Question: Name the type of graph shown.
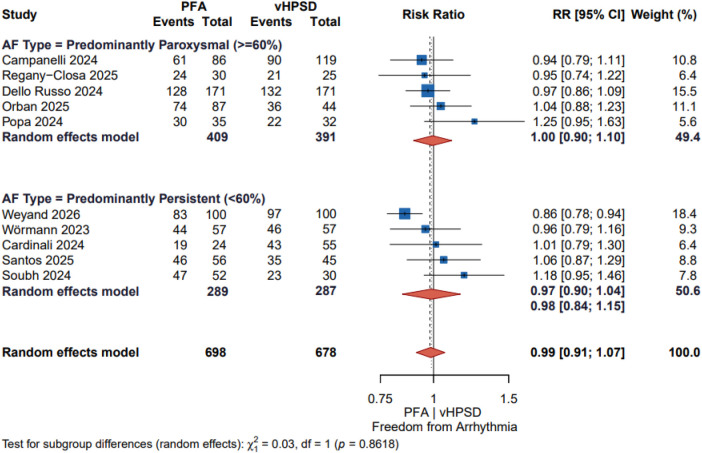
Answer: forest